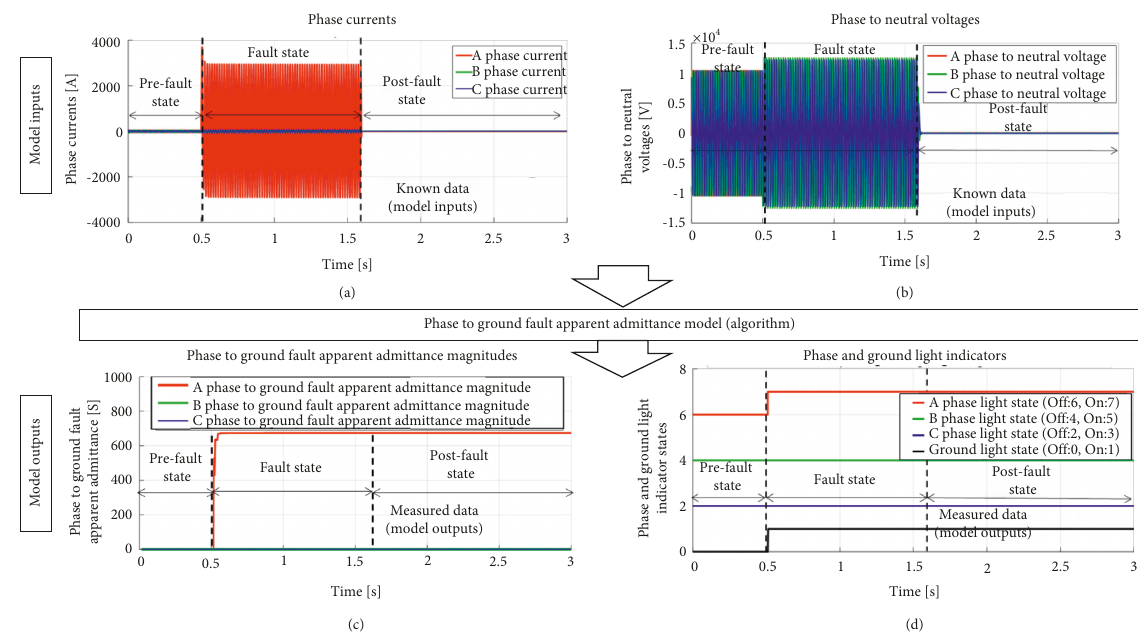
Figure 8: PGFA admittance model (a, b) inputs and (c, d) respectively. The TN and FP values were considered when the non-fault-predicted values matched and did not match (prefault state) and faulted (fault state) situations. The the measured values, respectively. The confusion matrix for the PGFA admittance method was created based on using the 105 measured values from Table 6. The measured TP , FP , TN , and FN values were 64, 0, 35, and 6, respectively. The measured TP , FP , TN , and FN values in percent were calculated for the 105 sets, and the results are shown in Table 6 shows the predicted values and measured true Figure 9. positive ( TP ), false positive ( FP ), true negative ( TN ), and The results from the confusion matrix ( TP , FP , TN , and false negative ( FN ) values from the tests. The TP and FN FN values) were used to calculate the class statistics values values were considered when the fault-predicted values such as the accuracy (Accuracy (%)), precision (Precision matched and did not match the measured values,